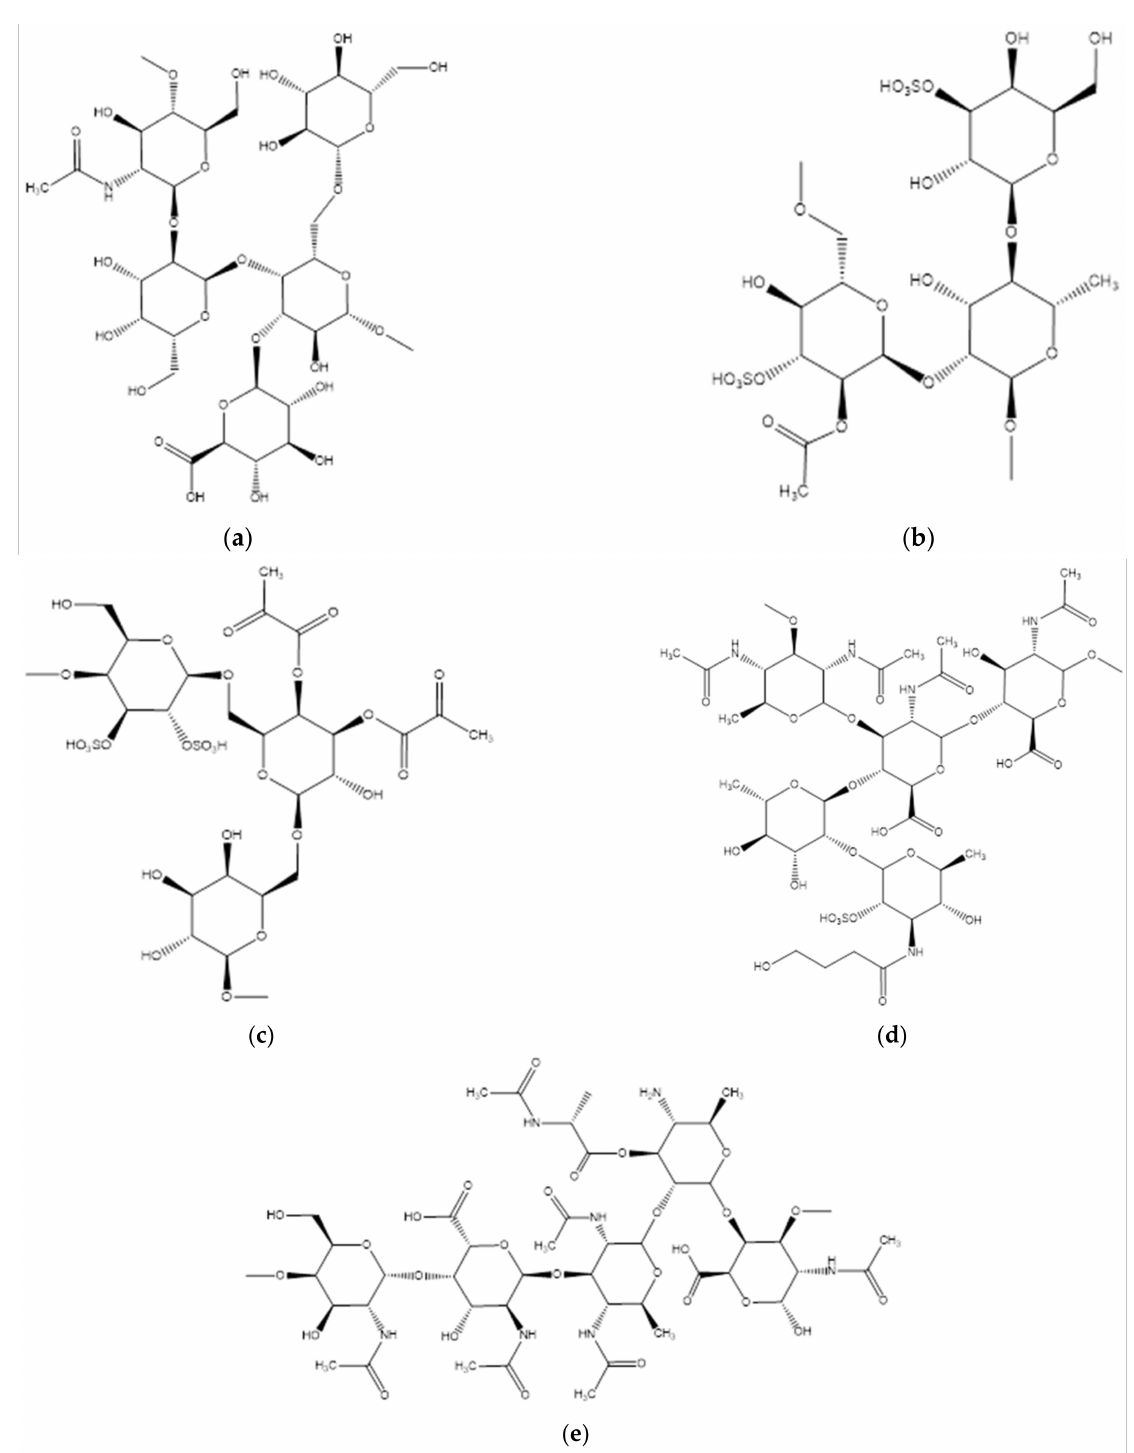
Figure 2. Alginate lyase structures of algae [159]. ( a ) Alginate lyase from P. Algicola ; ( b ) alginate lyase from L. Japonica ; ( c ) alginate lyase from U. Pinnatifida ; ( d ) alginate lyase from P. arborescens Holmes ( e ) alginate lyase from I. halotolerans